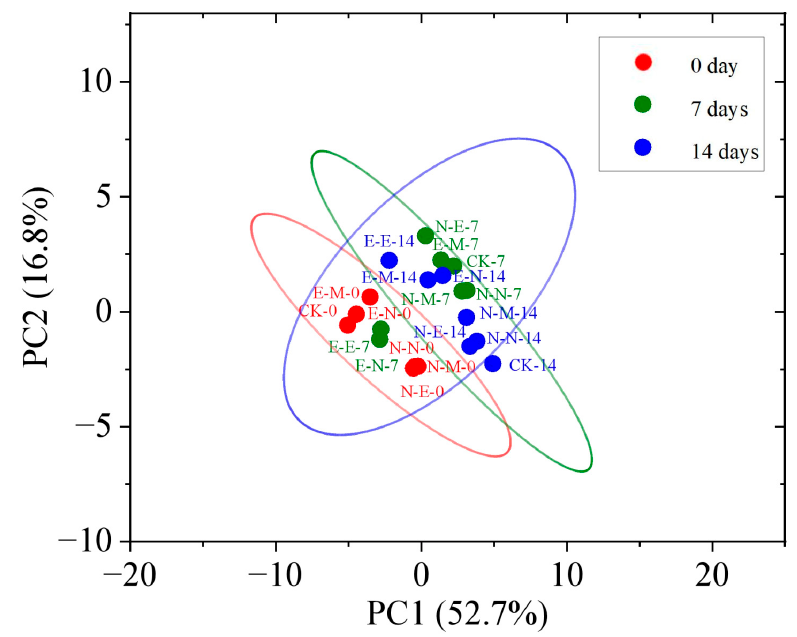
Figure 6. PCA analysis results of amino acid.